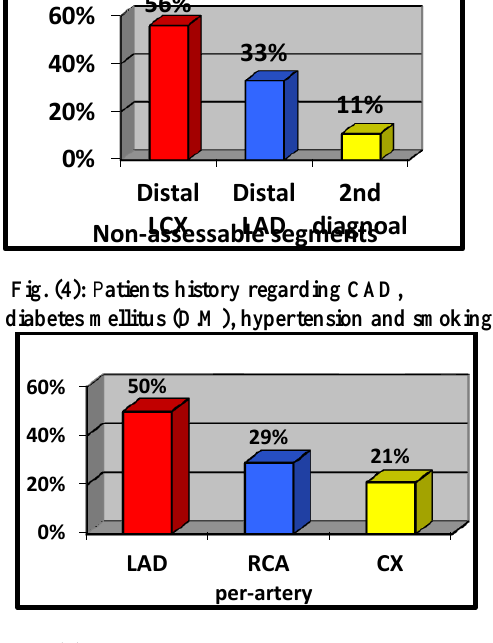
Fig. (5): Distribution of the non-assessable “excluded” segments.